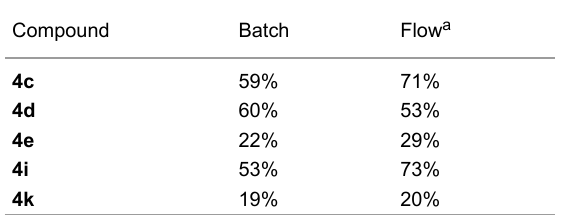
Table 3: Comparison of yields obtained in batch and under flow condi- tions. Compound